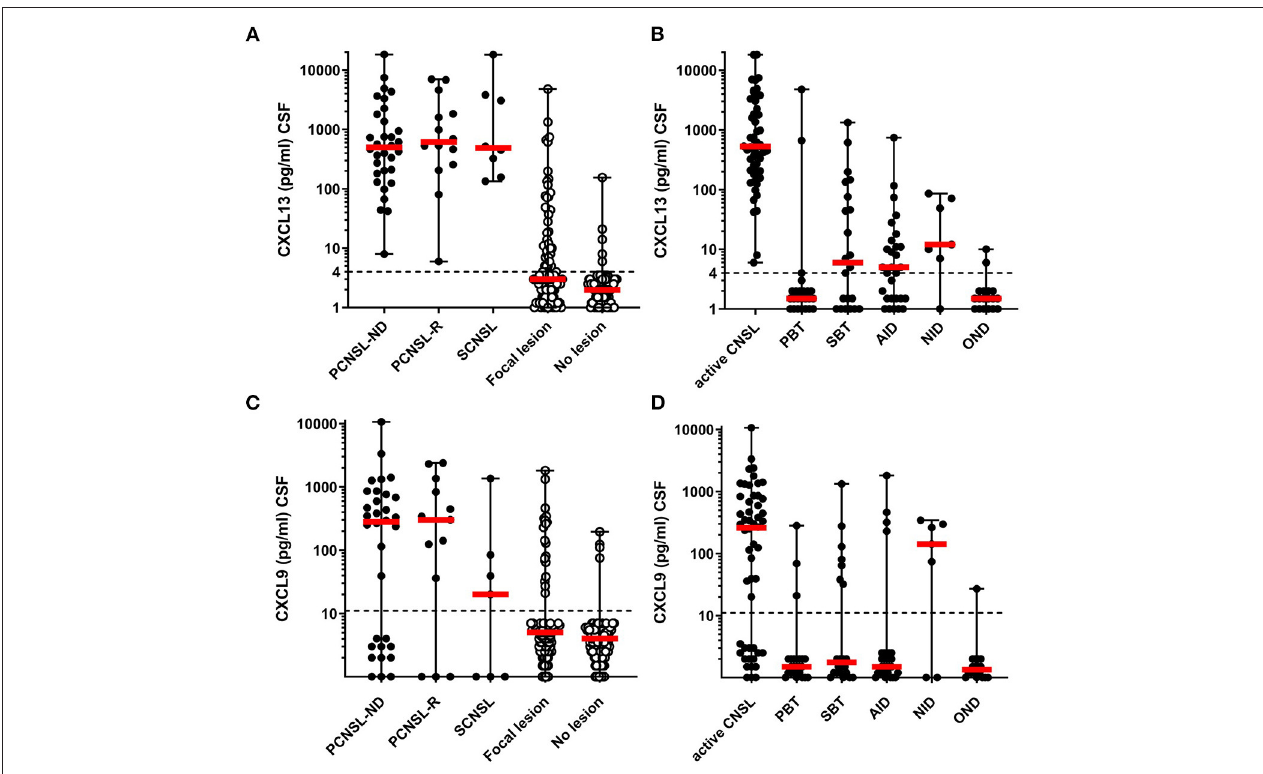
FIGURE 1 | CXCL13 and CXCL9 levels in CNSL and other lesions. CXCL13 CSF levels (A,B) , and CXCL9 CSF levels (C,D) were determined in samples for patients with CNSL and other lesional brain pathologies. (A,C) CSF levels of CXCL13 and CXCL9 were compared between patients with newly-diagnosed primary CNSL (PCNSL-ND), PCNSL in relapse (PCNSL-R), secondary CNSL (SCNSL), and all lesional pathologies grouped together (Focal lesions) as well as patients with other non-lesional pathologies serving as negative controls (No lesion). (B,D) CXCL13 and CXCL9 levels were compared between all patients with active CNSL and those with other lesional pathologies subcategorized into primary brain tumors (PBT), secondary brain tumors (SBT), autoimmune neuroinflammatory diseases (AID), neuroinfectious diseases (NID), and other lesions (OND). The dotted line in each diagram depicts the detection limit of each chemokine. Values below the detection limit were counted as 0 for calculation processes but were assigned different values in the diagram for better visualization of the number of probes below the limit.